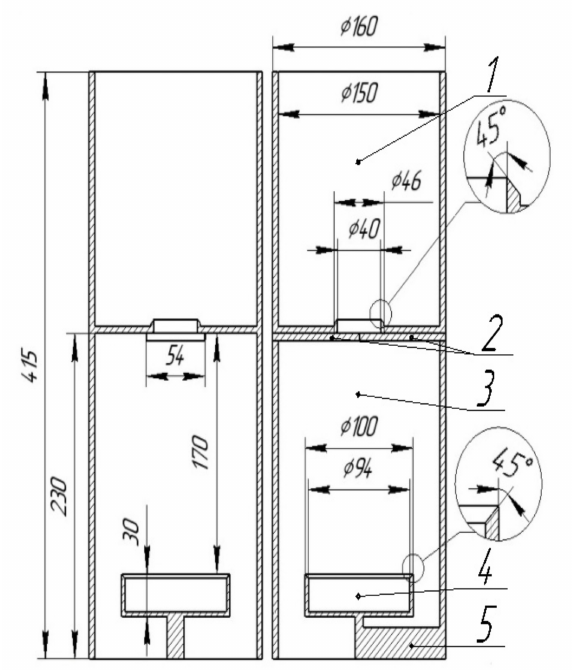
Figure 2. Sandglass test: (1) Upper vessel with a hole in the center of the bottom; (2) left and right plugs; (3) cylinder; (4) inner vessel; (5) micro load